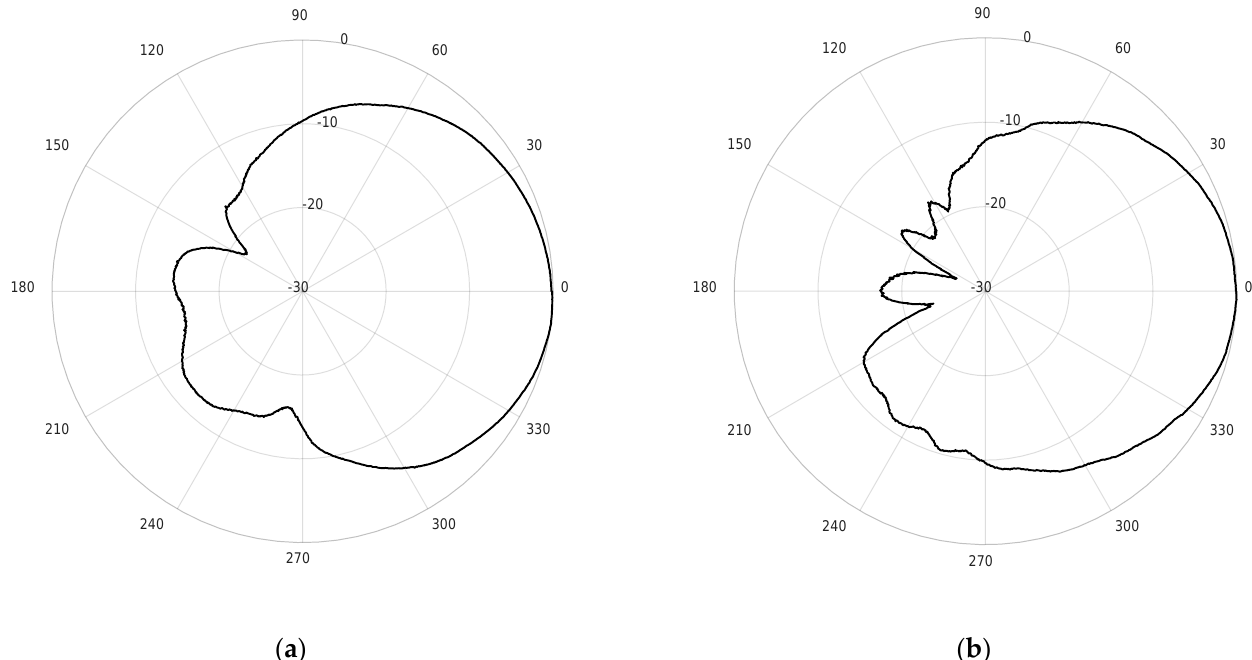
Figure 11. Measured radiation pattern at plane Phi = 0° normalized to zero (dB): ( a ) 1.574 GHz; ( b ) 2.44 GHz.